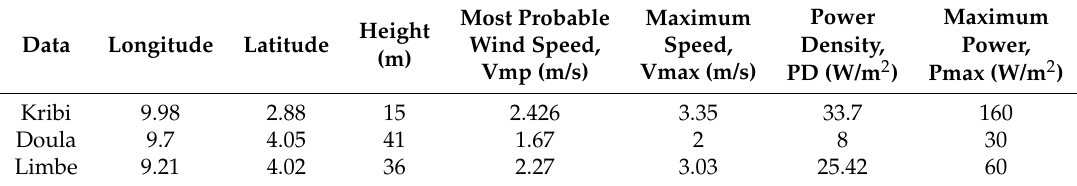
Table 4. Wind characteristics for three sites in Cameroon for onshore wind farm installation [44].